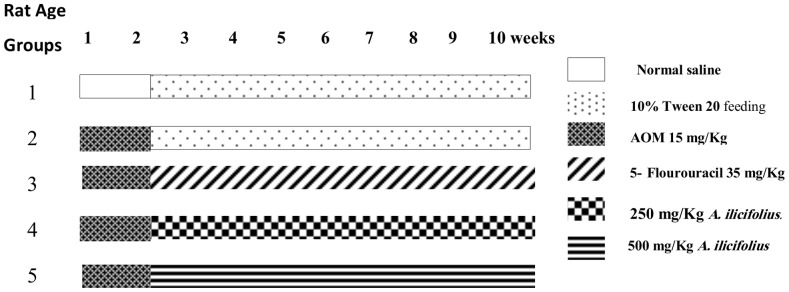
Experimental protocol for AOM-induced colonic aberrant crypt foci formation in male rats.The animals were randomly divided into 5 groups and fed with 10% Tween-20 for the normal control. AOM was given once a week for 2 weeks at a dose of 15 mg/kg of body weight, by subcutaneous injection. 5-Fluorouracil was administered at 35 mg/kg by intraperitoneal injection. A. ilicifolius was fed at 250 and 500 mg/kg.